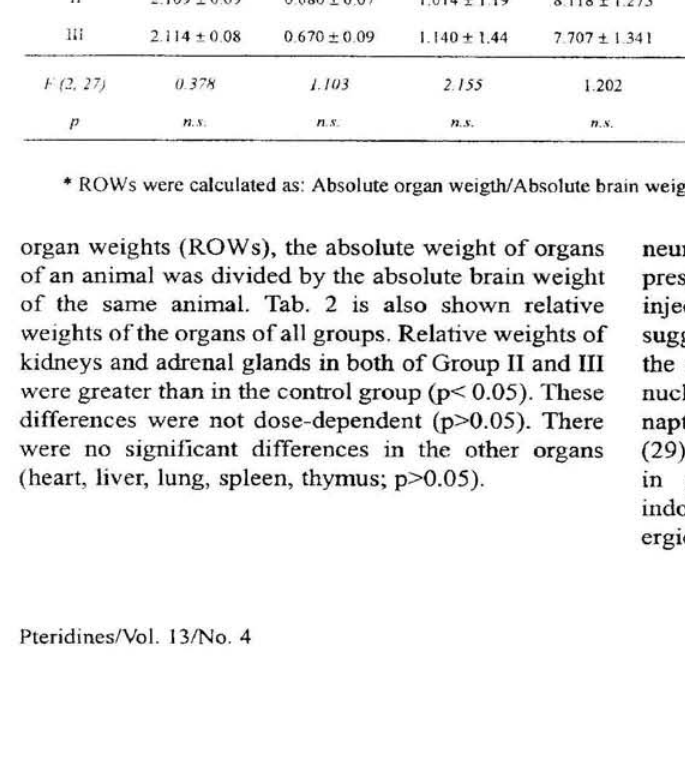
Pteridines/Vol. 13/No.